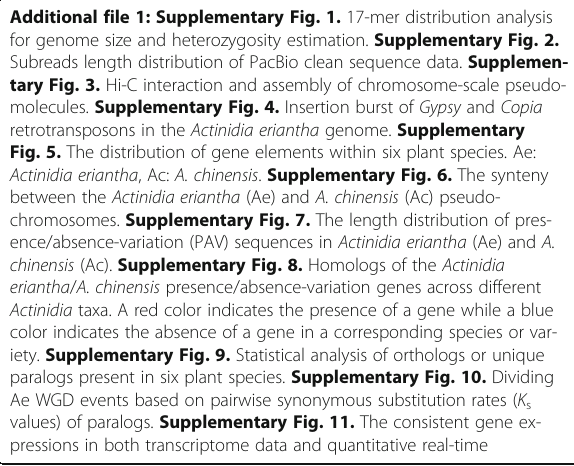
molecules. Supplementary Fig. 4. Insertion burst of Gypsy and Copia retrotransposons in the Actinidia eriantha genome. Supplementary Fig. 5. The distribution of gene elements within six plant species. Ae: Actinidia eriantha , Ac: A. chinensis . Supplementary Fig. 6. The synteny between the Actinidia eriantha (Ae) and A. chinensis (Ac) pseudo- chromosomes. Supplementary Fig. 7. The length distribution of pres- ence/absence-variation (PAV) sequences in Actinidia eriantha (Ae) and A. chinensis (Ac). Supplementary Fig. 8. Homologs of the Actinidia eriantha / A. chinensis presence/absence-variation genes across different Actinidia taxa. A red color indicates the presence of a gene while a blue color indicates the absence of a gene in a corresponding species or var- iety. Supplementary Fig. 9. Statistical analysis of orthologs or unique paralogs present in six plant species. Supplementary Fig. 10. Dividing Ae WGD events based on pairwise synonymous substitution rates ( K s values) of paralogs. Supplementary Fig. 11. The consistent gene ex- pressions in both transcriptome data and quantitative